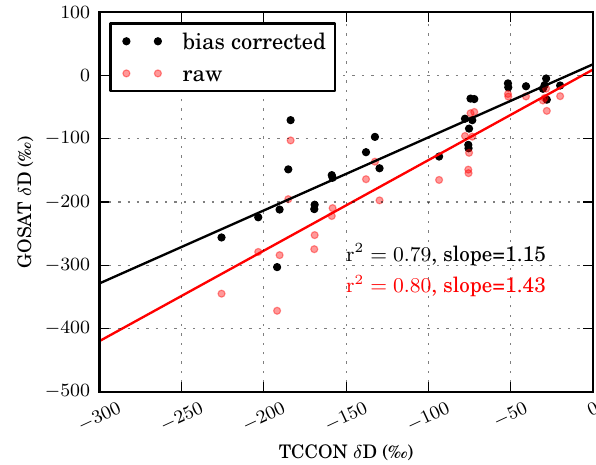
Fig. 8. Scatter plot and linear fit of monthly δ D over the Lamont (Oklahoma) TCCON station (TCCON vs. GOSAT)